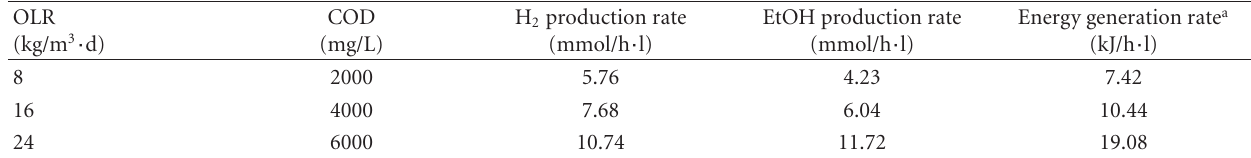
Table 2: Performance of H 2 and ethanol production rate as well as energy generation rate with CSTR operated at di ff erent OLR using molasses as the carbon source.